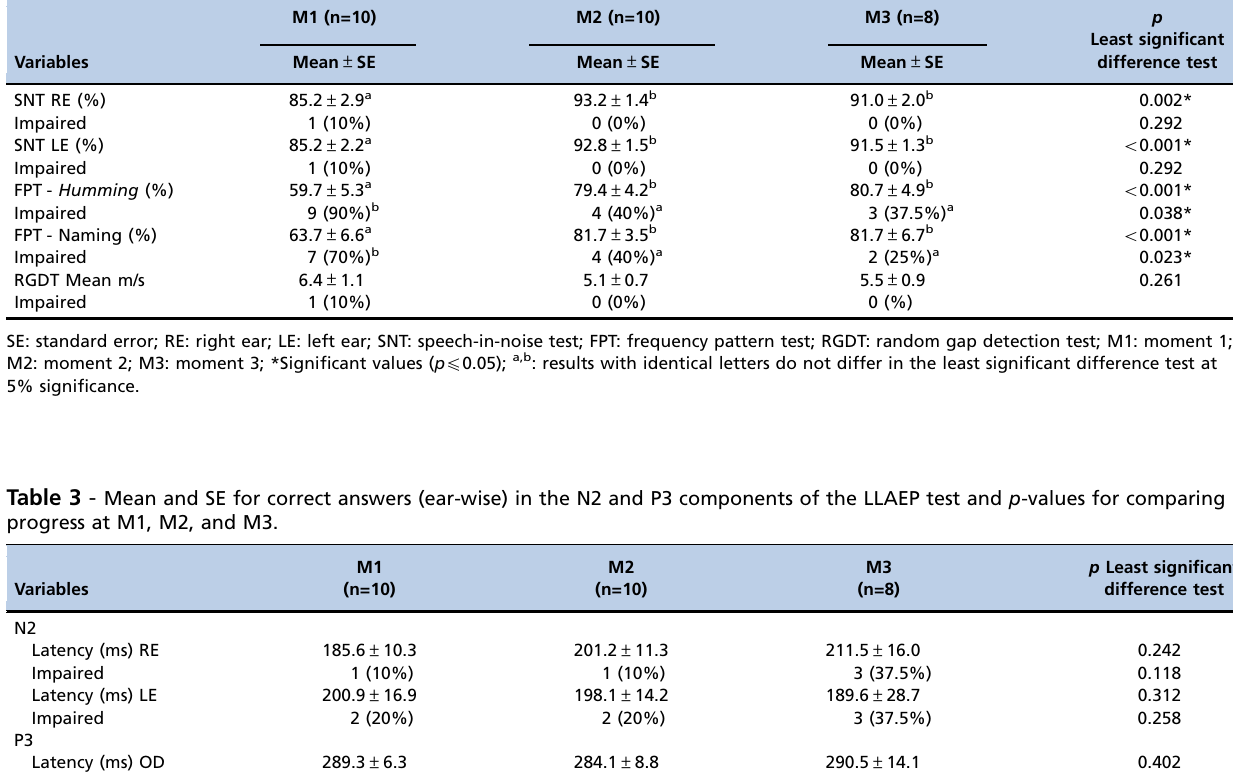
Table 2 - Mean and SE for correct answers (ear-wise) in the SNT, FPT, and RGDT, with p -values for comparison at M1, M2, and M3.